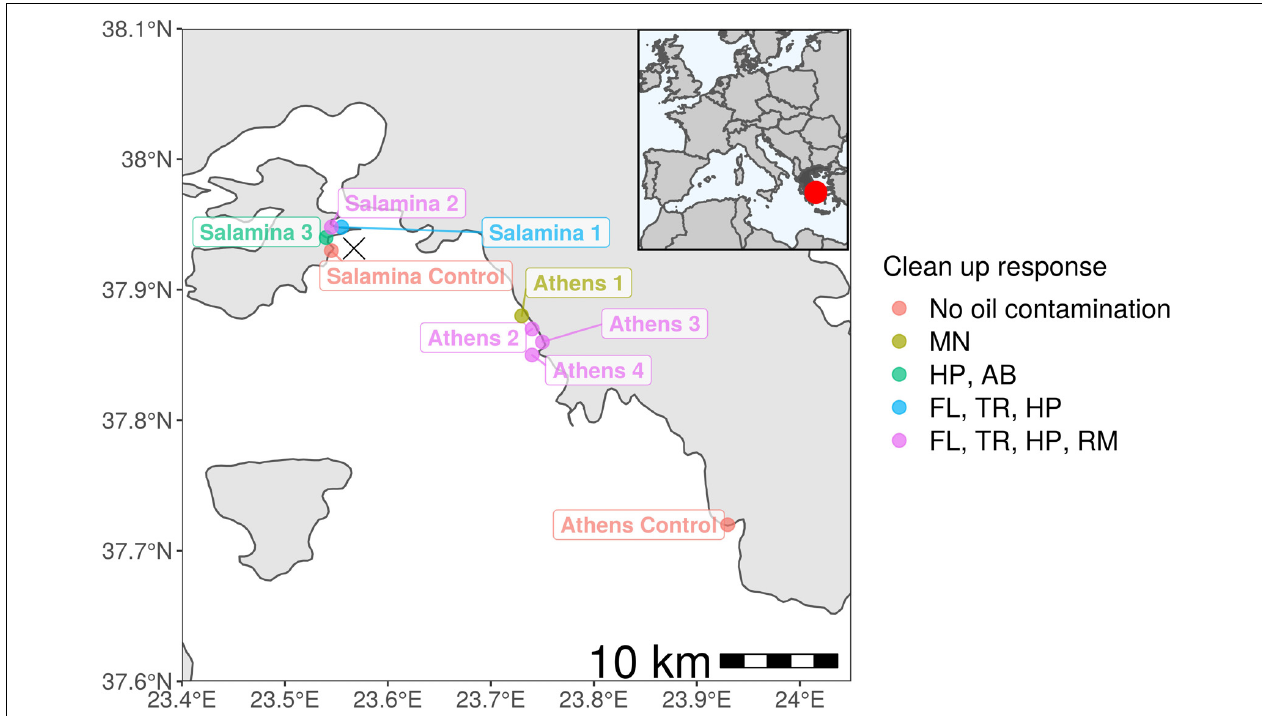
FIGURE 1 | Sampling sites from the Agia Zoni II oil-spill (marked as an X where tanker sank) in Greece (inlet; dark gray; red dot highlights spill-site) and affected Athens Riviera and Salamina coastline. Abbreviations for clean-up response applied at oil-contaminated sample sites (Athens 1–4 and Salamina 1–3): MN (manual removal of tar balls), HP (high-powered washing, to remove oil from hard surfaces), AB (use of absorbents to collect floating oil from the water surface), FL (flushing of sediment with medium pressure water), TR (trenching, used in conjunction with flushing to collect oil), and RM (removal of coastal sediment, either washed and replaced or disposed in